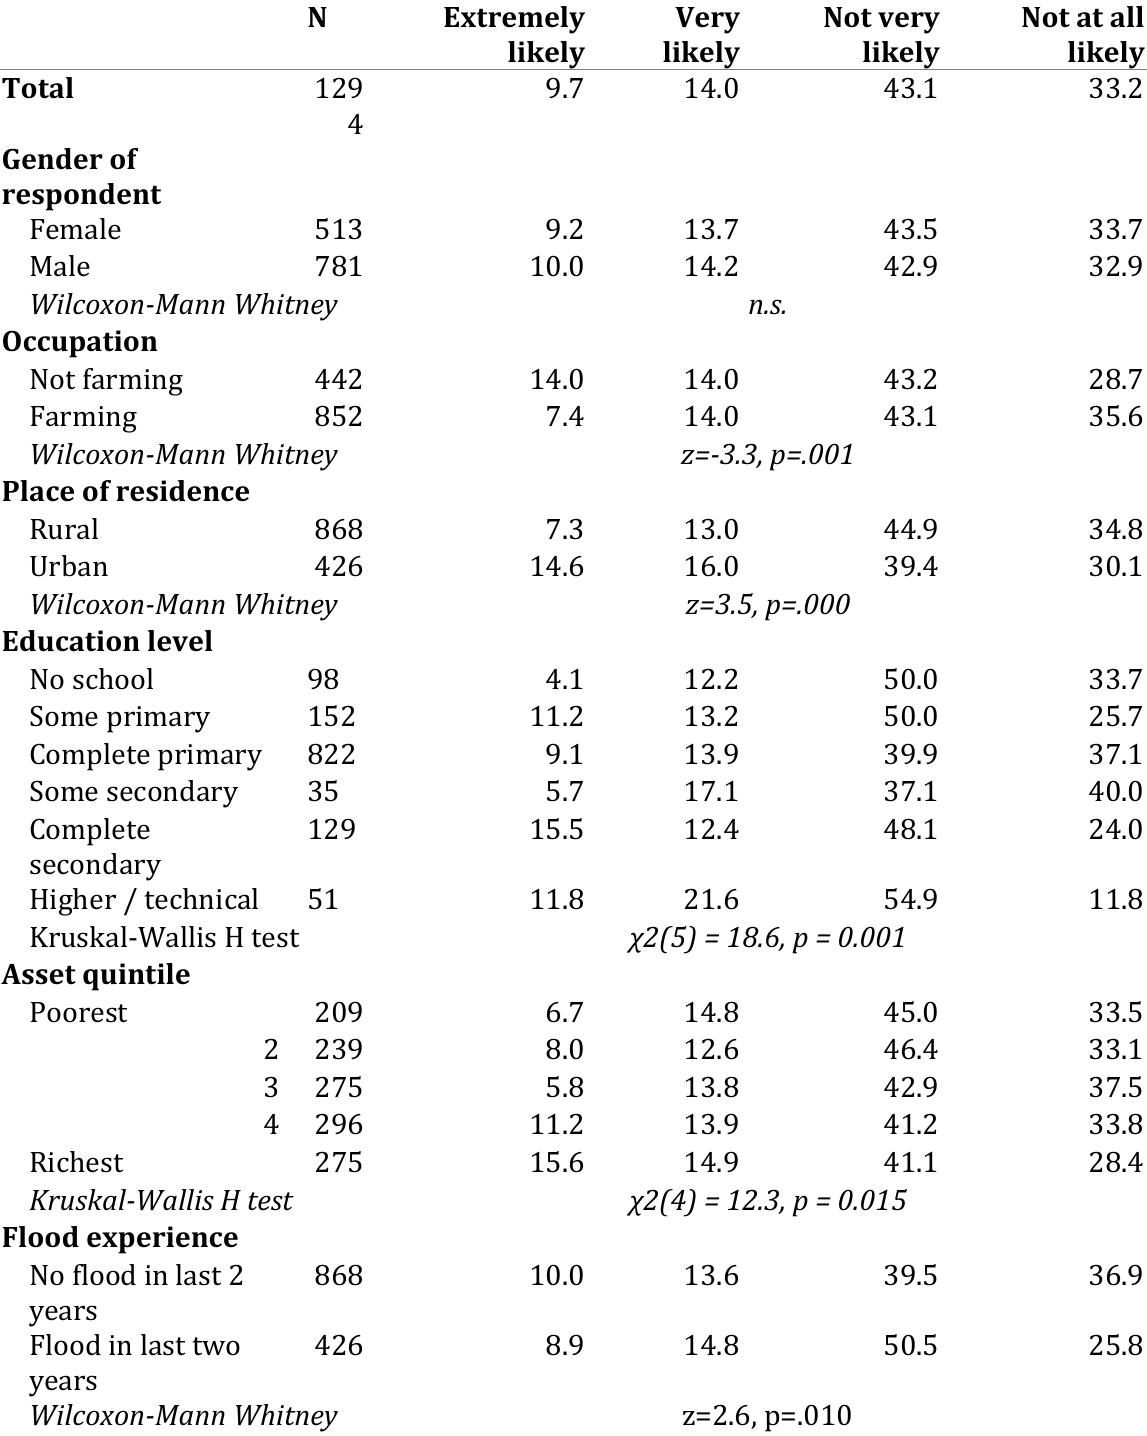
Table A1.5. Perceived capacity to be recover fully from an extreme flood by respondent